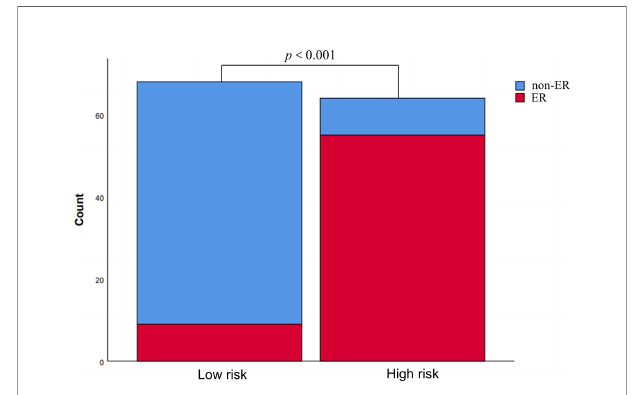
FIGURE 7 | Risk strati fi cation according to the nomogram. The risk of early recurrence was substantially higher in the high-risk group than in the low-risk